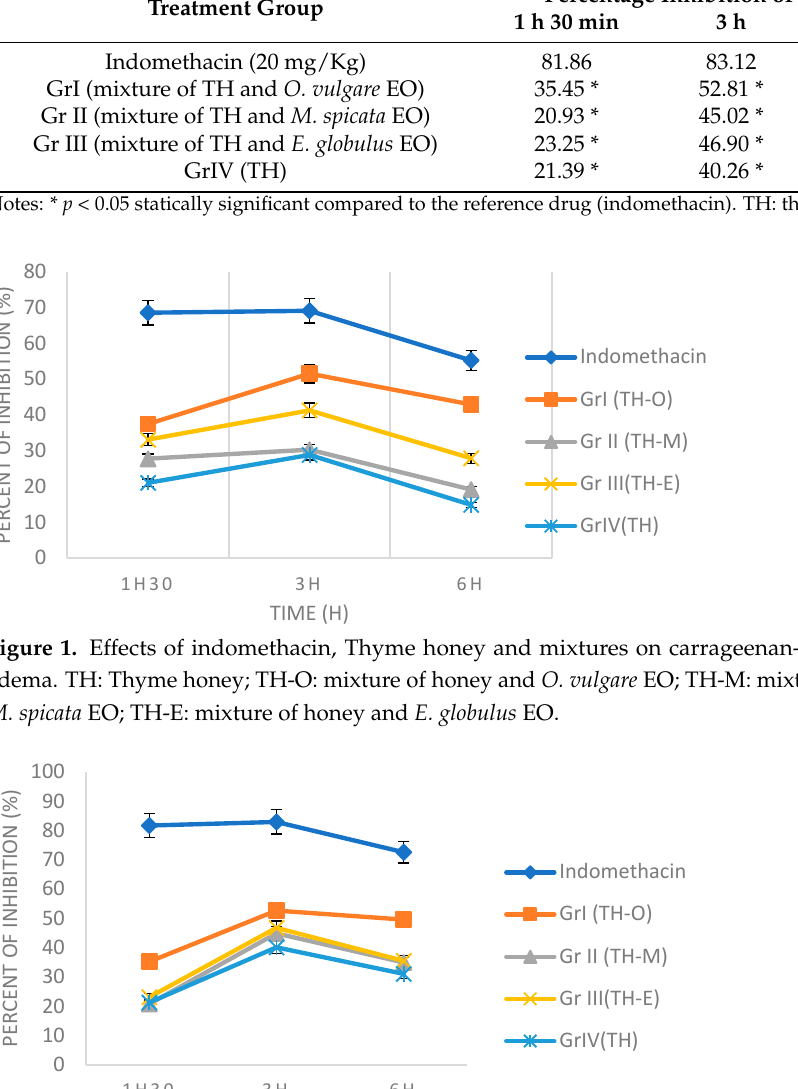
Table 9. Percentage inflammation inhibition by Thyme honey and mixtures on experimental trauma- induced rat paw edema.